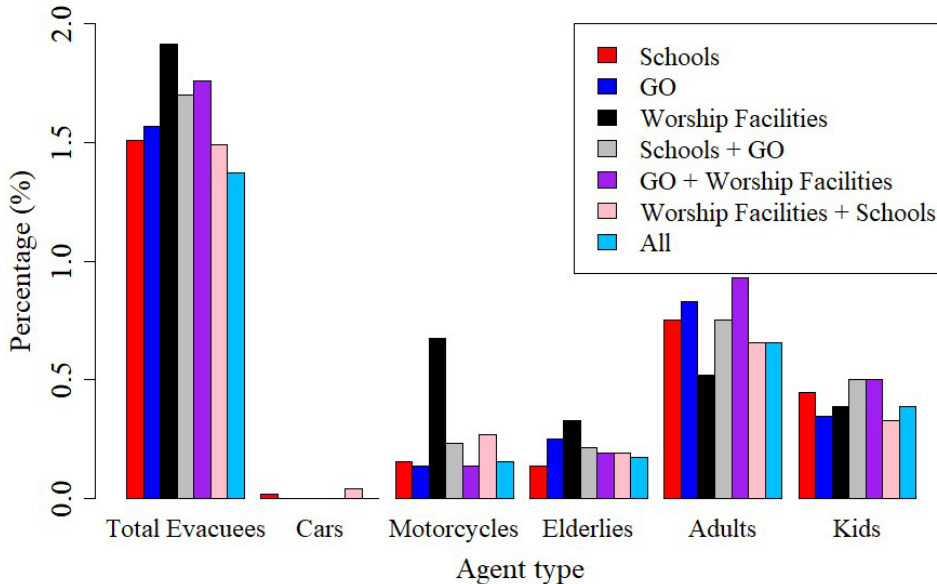
Figure 5. Total deaths (%) depending on the shelter